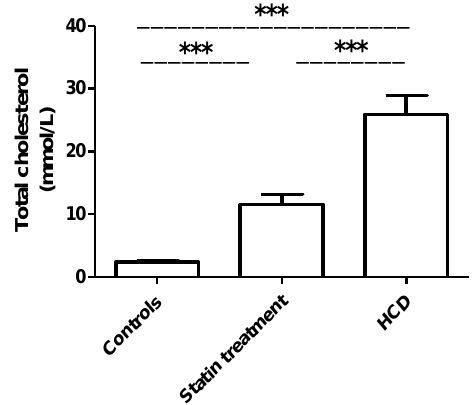
Figure 4. Total cholesterol plasma concentration of the rat. Control group ( n = 7), statin therapy ( n = 8), and high-cholesterol diet (HCD; n = 8). *** p < 0.001 .